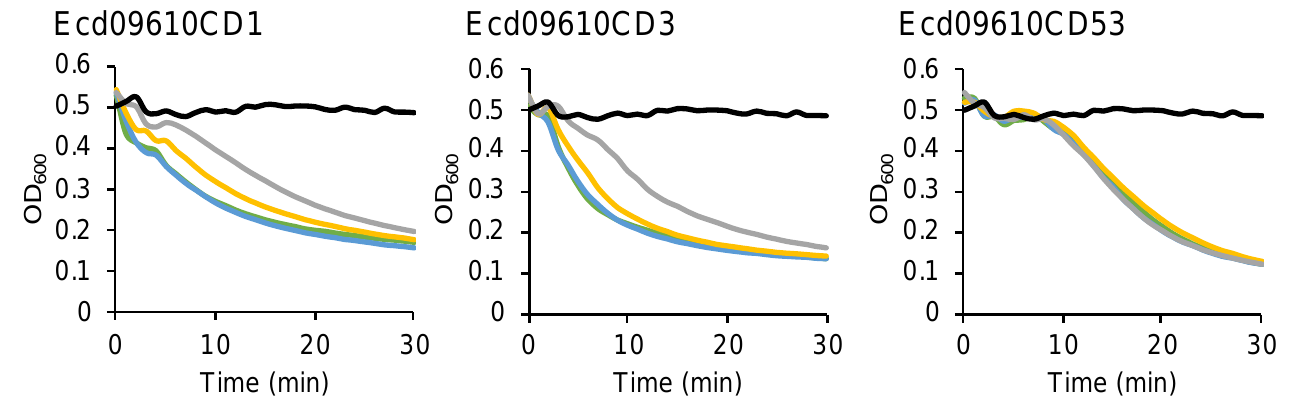
Figure 3. Effect of lyophilization on the lytic activity of proteins. Ecd09610CD1 (0.08 μM), Ecd09610CD3 (0.15 μM), and Ecd09610CD53 (0.3 μM) or buffer was added to the cells, and OD 600 was measured at 1-min intervals for 30 min. No lyophilized protein (green), lyophilized protein (blue), lyophilized and stored at 4 °C, for 4 weeks (yellow), lyophilized and stored at room temperature for 4 weeks (gray), and buffer (black) are shown.